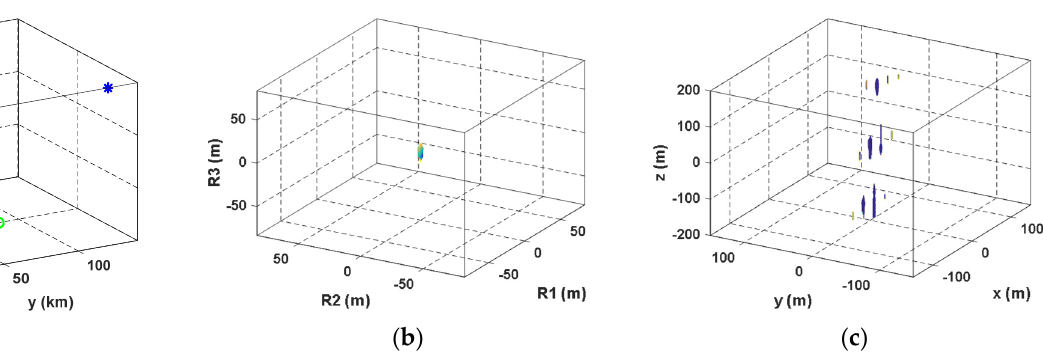
Figure 6. ( a ) Geometry of the receiver network with the lightning flash at [0, 0, 6] km; ( b ) in the RD space, the equivalence cell is a point; ( c ) in the geographic space, the equivalence cell is almost a point.